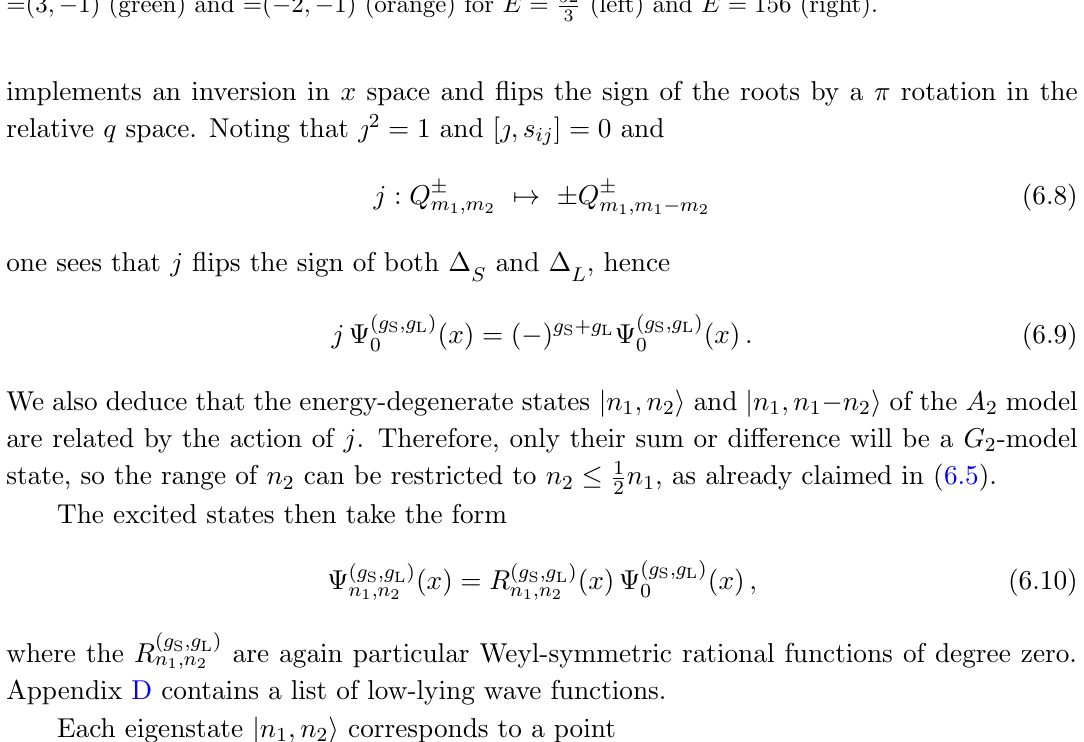
(left) and E = 156 3